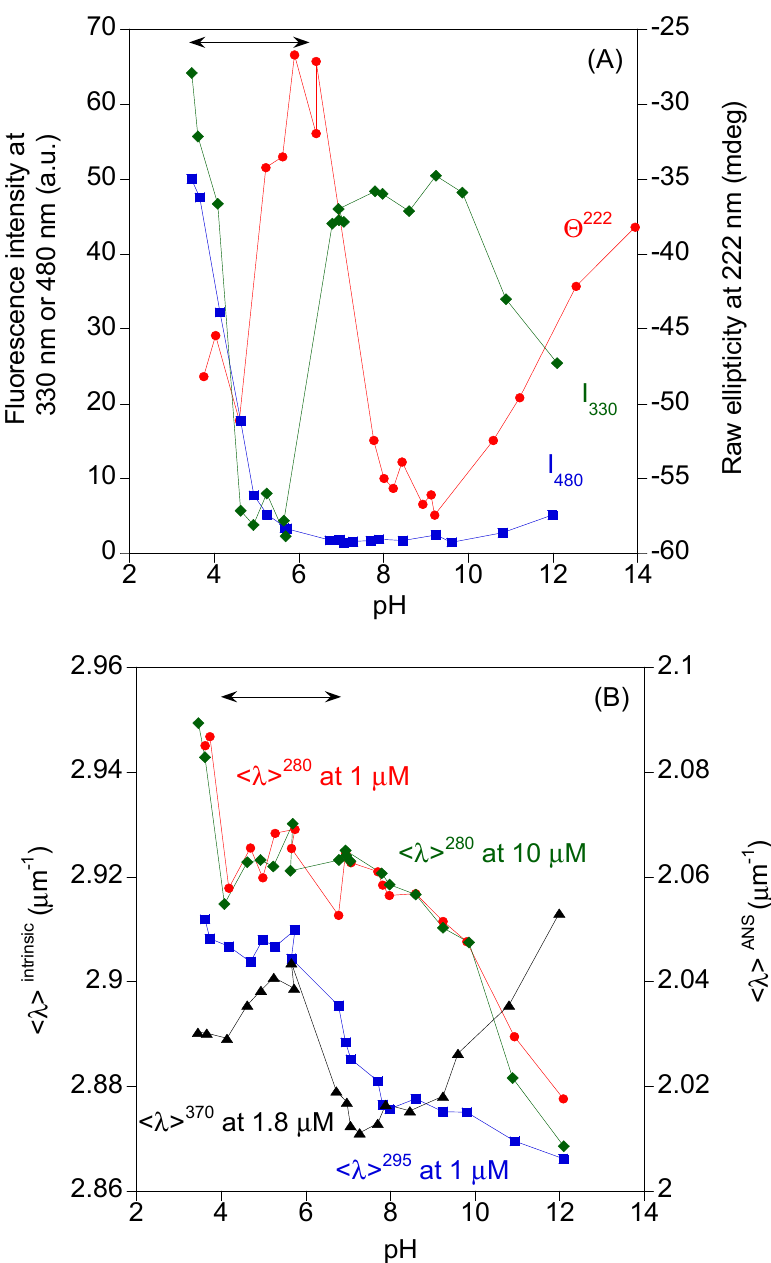
Figure 1. pH-induced structural changes in bsHPrK/P, followed by spectroscopic techniques: ( A ) Changes in the intrinsic fluorescence intensity emission at 330 nm, after excitation at 280 nm (left axis); scaled-up ANS fluorescence emission at 480 nm (left axis); and raw ellipticity at 222 nm (right axis). Experiments were carried out at 1.8 µ M of protein concentration (for all techniques) and 25 ◦ C. ( B ) Changes in the < λ >, after excitation either at 280 or 295 nm (left axis), after excitation at 370 nm (right axis) at different protomer concentrations as indicated in the figure. The lines are drawn to guide the eye. The experiments with each technique were repeated three times, but only a complete, single titration is shown for each technique. The double-arrow line at the top in both panels indicates the pH range where precipitation of the protein was observed. Samples at those pH values were centrifuged to remove the precipitate.